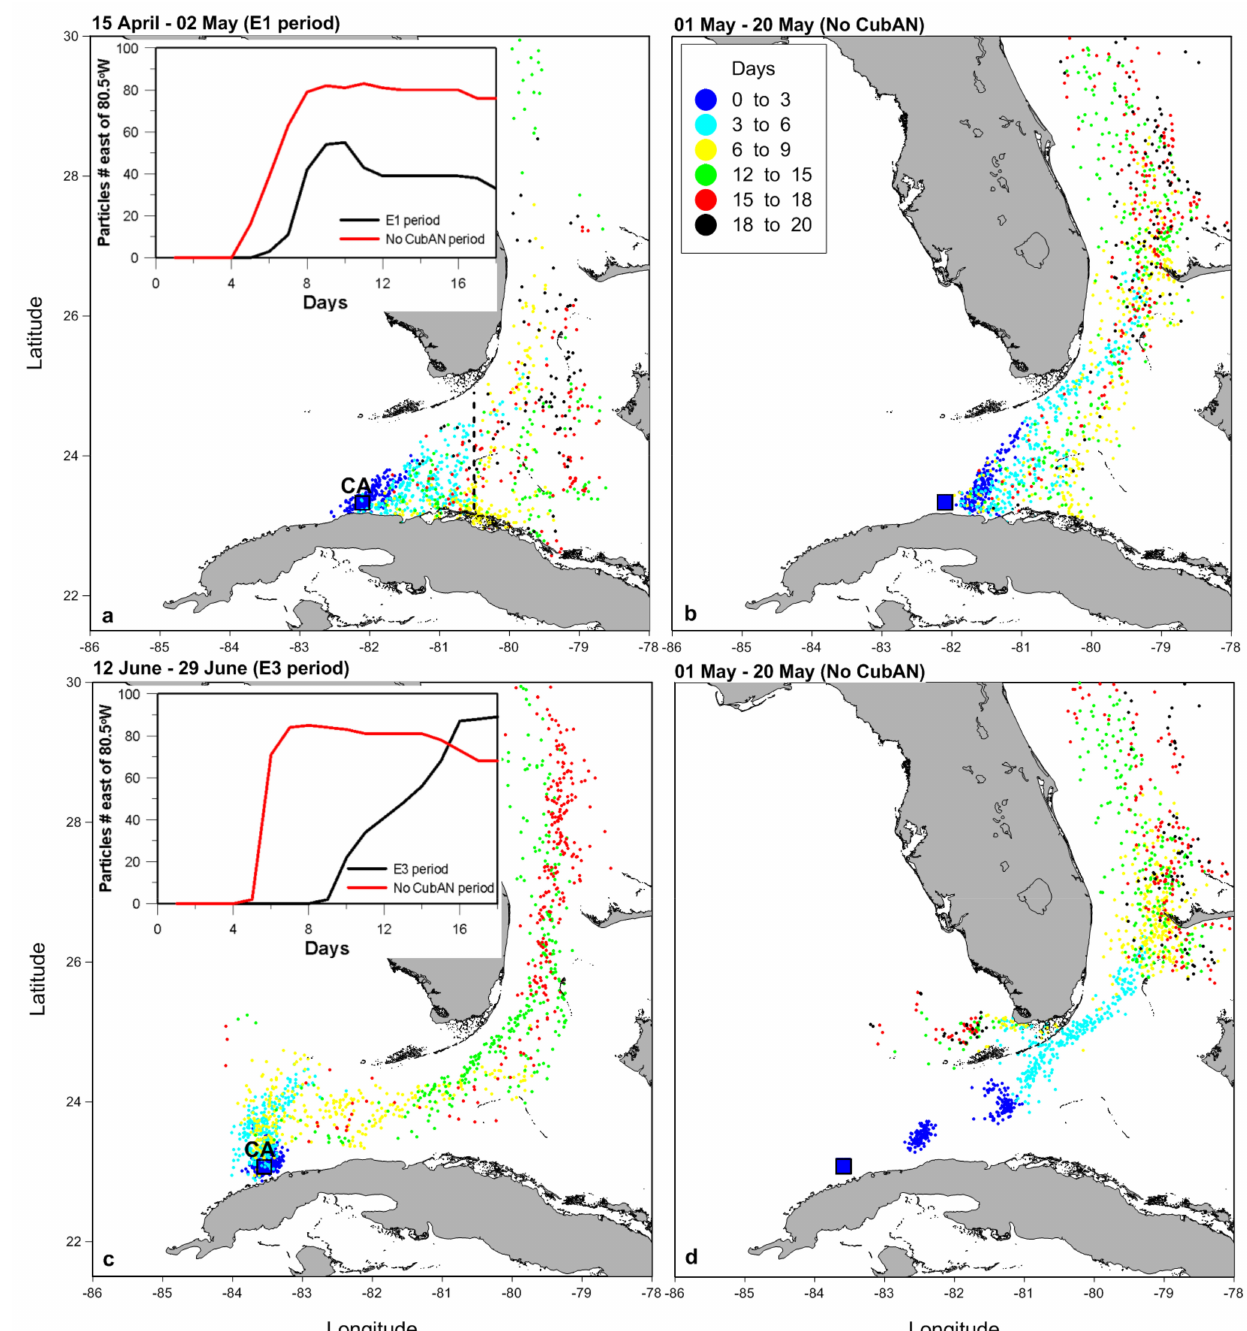
Figure A1. Snapshots of the total monthly evolution of 100 particles released in the Straits of Florida (release area marked with a black square) on ( a ) 15 April 2010 (E1 period, release at 82 ◦ W), ( b ) 1 May 2010 (No CubAN period and release at 82 ◦ W), ( c ) 12 June 2010 (E3 period, release at 83.5 ◦ W) and ( d ) 1 May 2010 (No CubAN period and release at 83.5 ◦ W) as derived by the GoM-HYCOM 1/50 simulations. The positions of CubANs are marked in panels ( a , c ). The number of particles detected daily east of 80.5 ◦ W during CubAN (black lines) and No CubAN (red line) periods are presented in the inserts of ( a , c ). The dashed line in ( a ) marks the section at 80.5 ◦ W that was used to compute the time series of particle